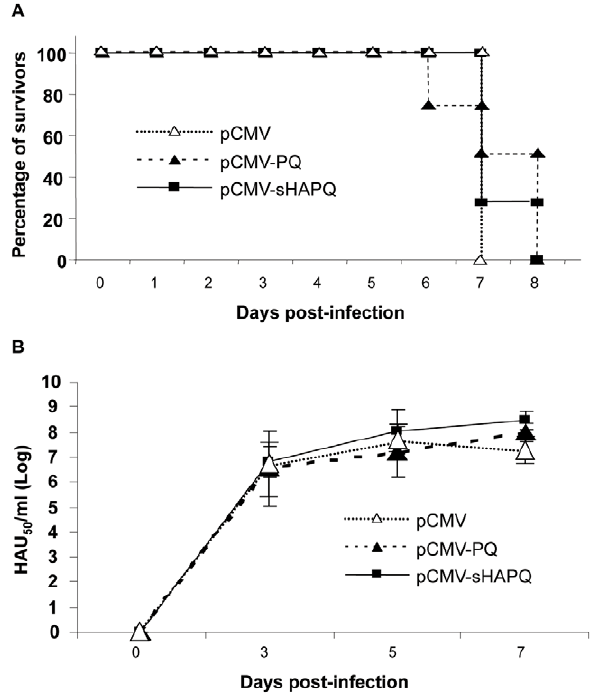
Figure 4. pCMV-sHAPQ does not protect against lethal ASFV challenge. (A) Surviving kinetics of pCMV, pCMV-pCMV-PQ and pCMV- sHAPQ immunized pigs after lethal challenge with ASFV (10 4 UHA of the E75 isolate). (B) Viremia kinetics of these same individuals after ASFV challenge (days 3, 5 and 7 post infection). Results are represented as the logarithm of HAU 50 /ml serum (mean and standard deviation from each group are shown).